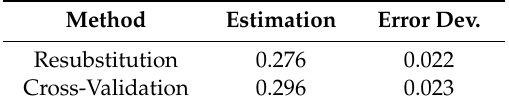
Table 1. Estimation risk for using YouTube (CHAID method). Method Table 2. Classification success for using YouTube.